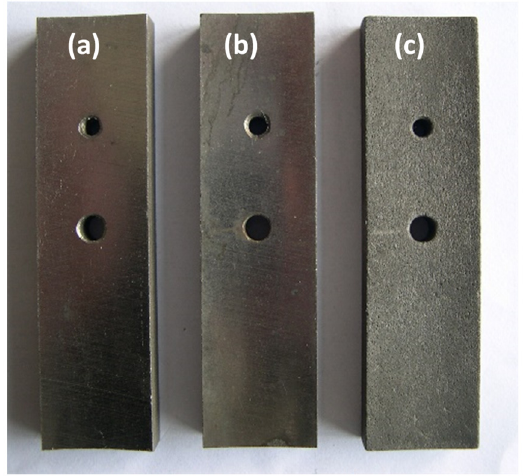
Figure 4. The surface diagrams of cylinder liners immersed in FFEO and EBF oils at 50 °C for 5 days. ( a ) Initial, ( b ) FFEO, ( c ) EBF.